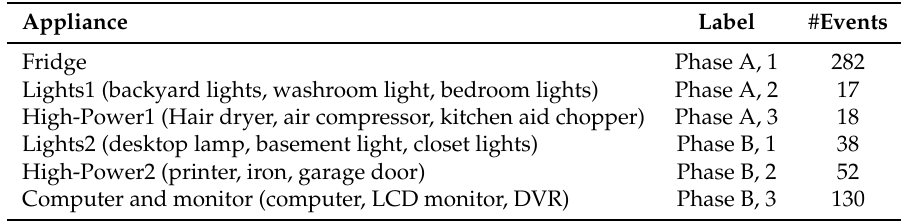
Table 2. Appliances used in Building-Level fUlly labeled dataset for Electricity Disaggregation (BLUED).